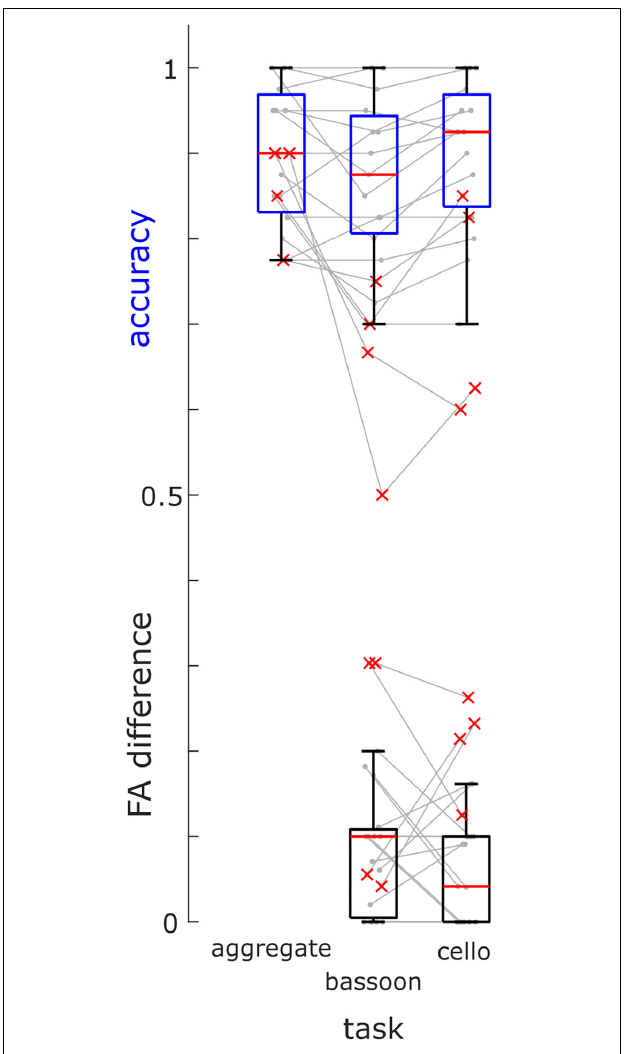
FIGURE 3 | Group Behavioral Results. Accuracies of triplet detection across all tasks (blue boxes) and FA differences between trials with triplets in the other instrument and trials without triplets (black boxes) for the bassoon and cello task for all participants (box = 25th percentile–median–75th percentile). Gray lines denote performances of single participants, red crosses indicate participants excluded from further